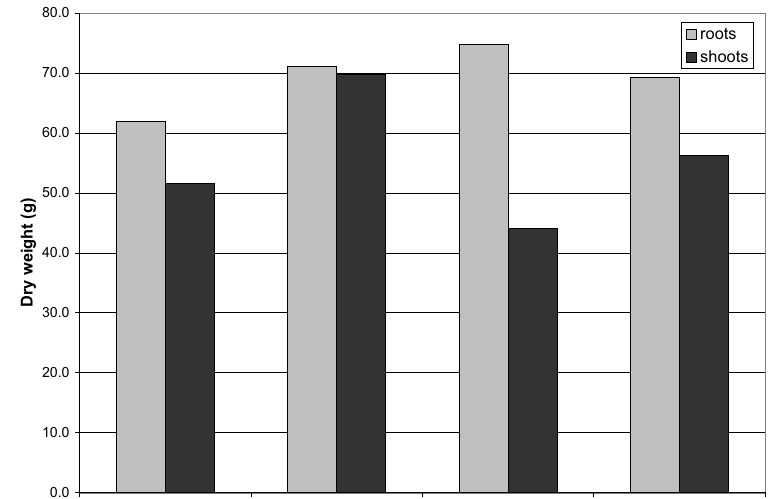
Fig. 4. Effect of water stress on biomass of infected and uninfected Zinfandel, Year 1, 2004.